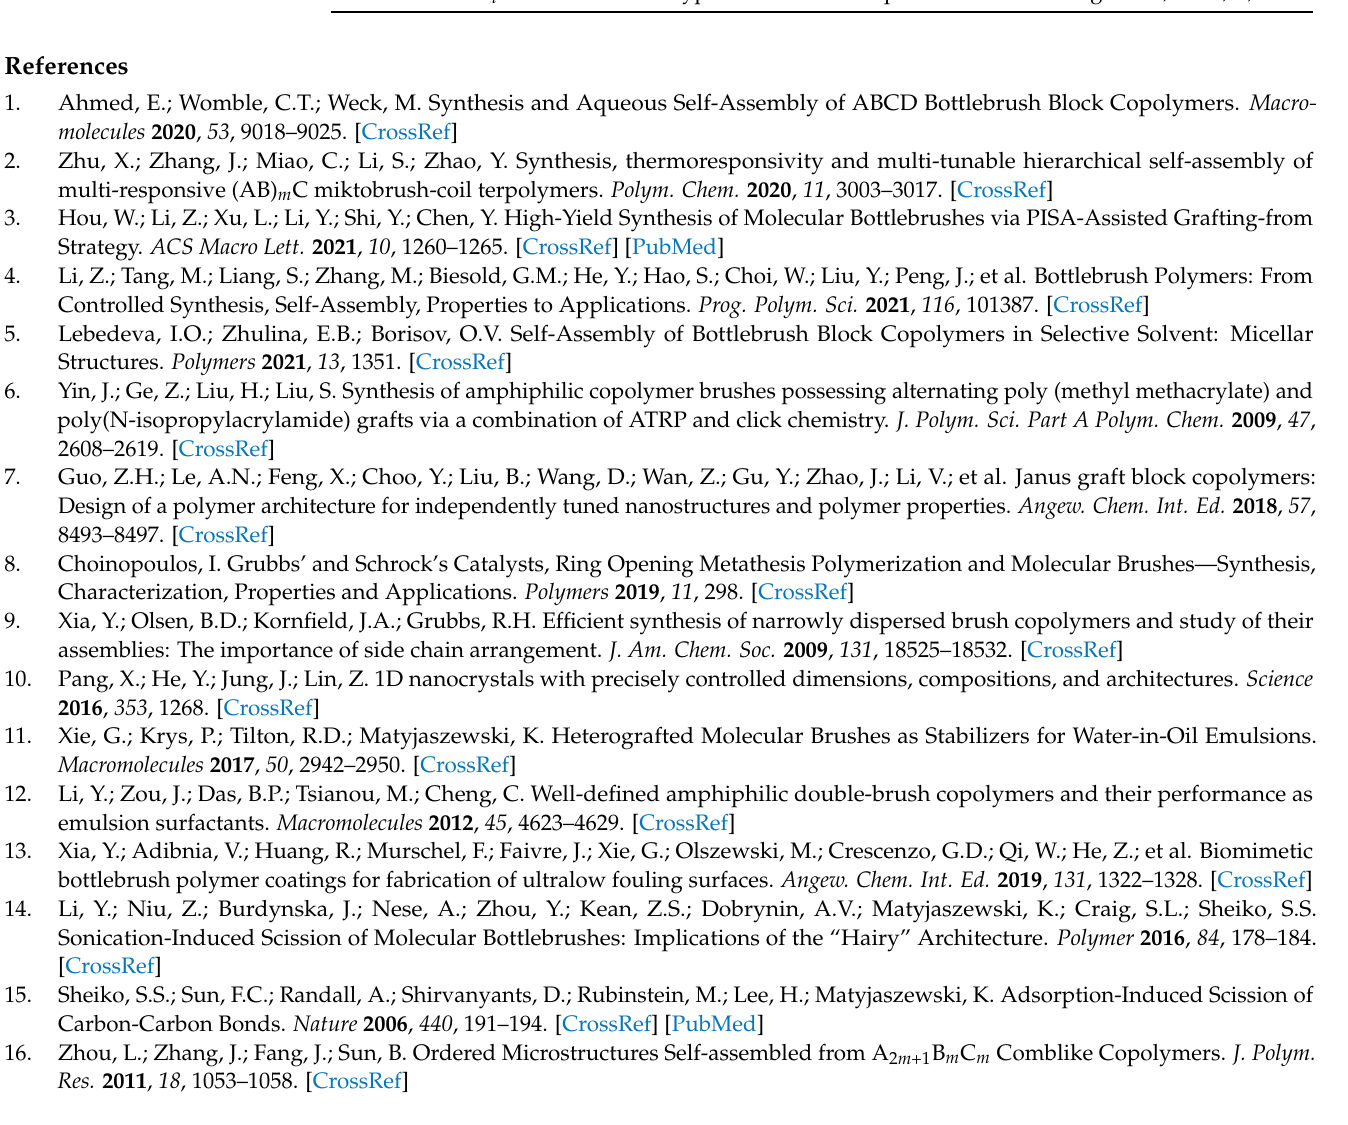
The partition function The end-segment distribution